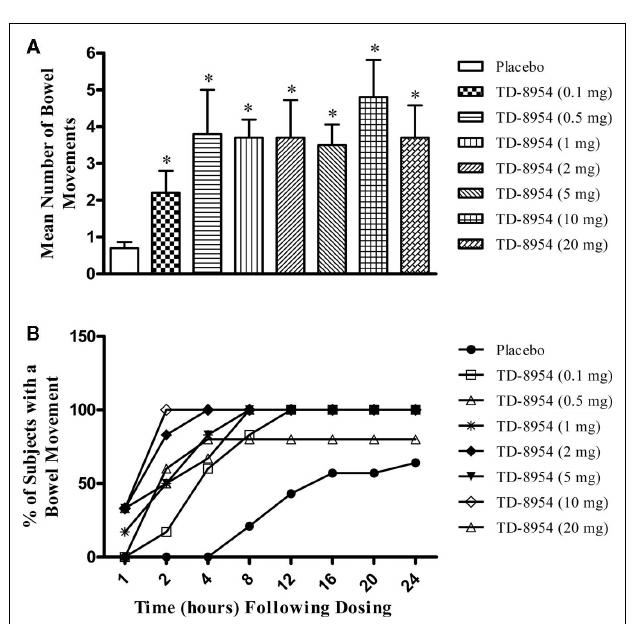
FIGURE 7 | (A) The mean number of bowel movements, and (B) the cumulative percentage of subjects responding with a bowel movement within 24h following the oral dosing ofTD-8954 (0.1–20mg) and placebo to healthy human subjects ( n = 5–14 per group). Each dose ofTD-8954 produced a statistically significant effect compared to placebo (* p < 0.03, Wilcoxon rank sum test vs.